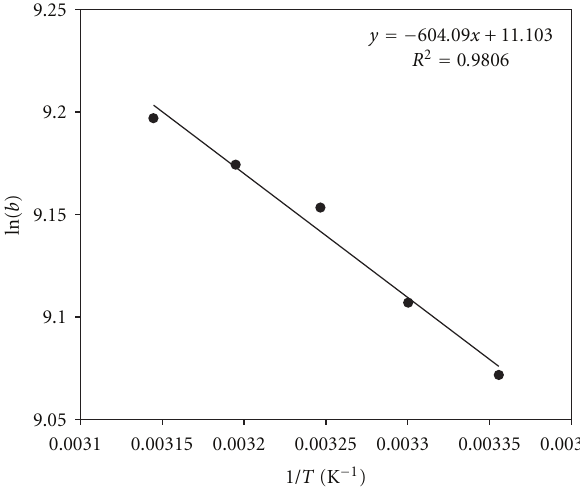
F 4: Vant Hoff plot for 2, 4-D adsorption at different temper-